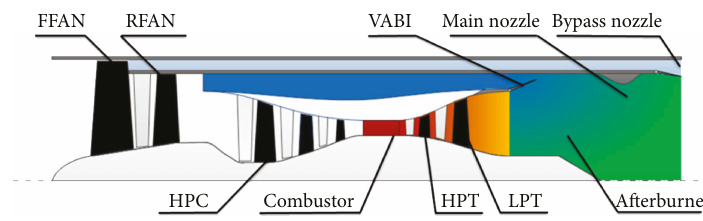
Figure 2: The main components of three-stream ACE.